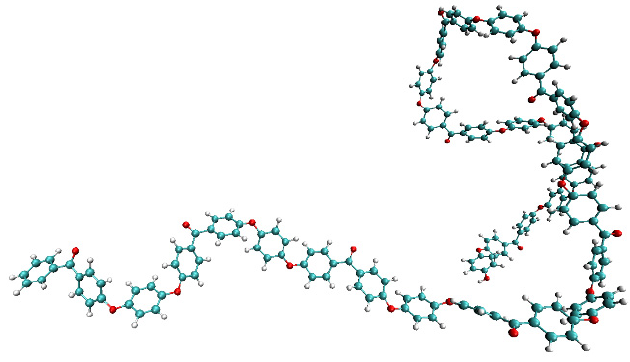
Figure 1. Chemical structure of PEEK.